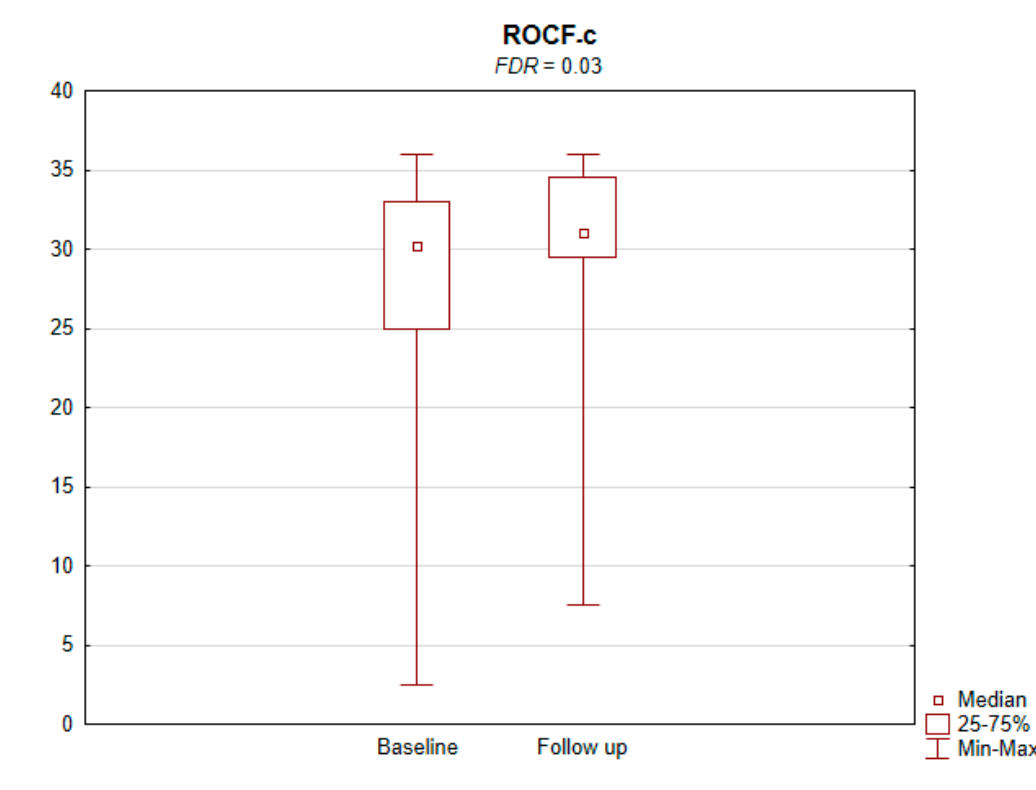
Figure 1. Rey–Osterrieth Complex Figure copy (ROCF-c) before and after the intervention. FDR — False Discovery Rate.